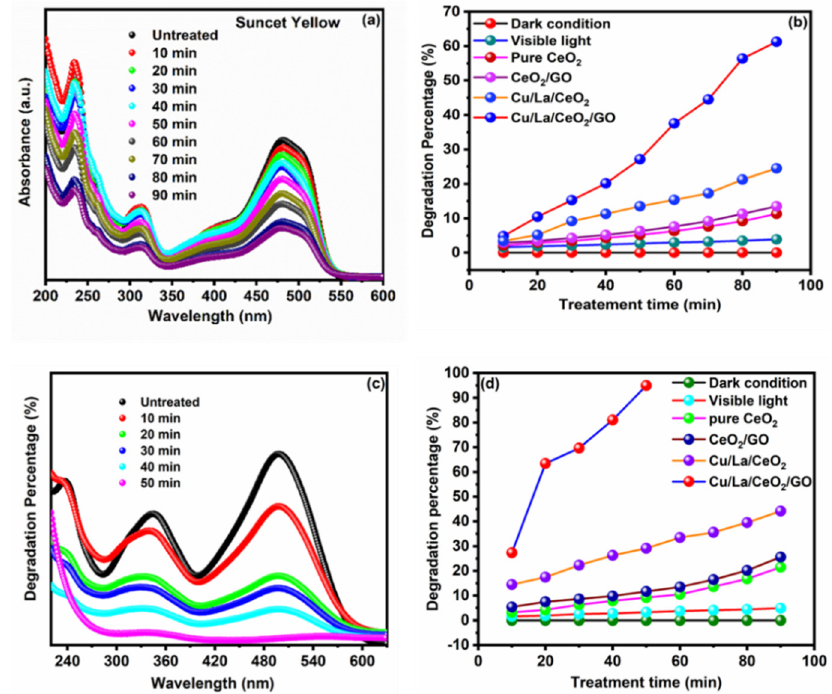
Figure 6. Photodegradation of SY and CR organic dyes using UV–vis spectra. ( a , b ) Absorption and degradation percentages of SY. ( c , d ) Absorption and degradation percentages of CR.